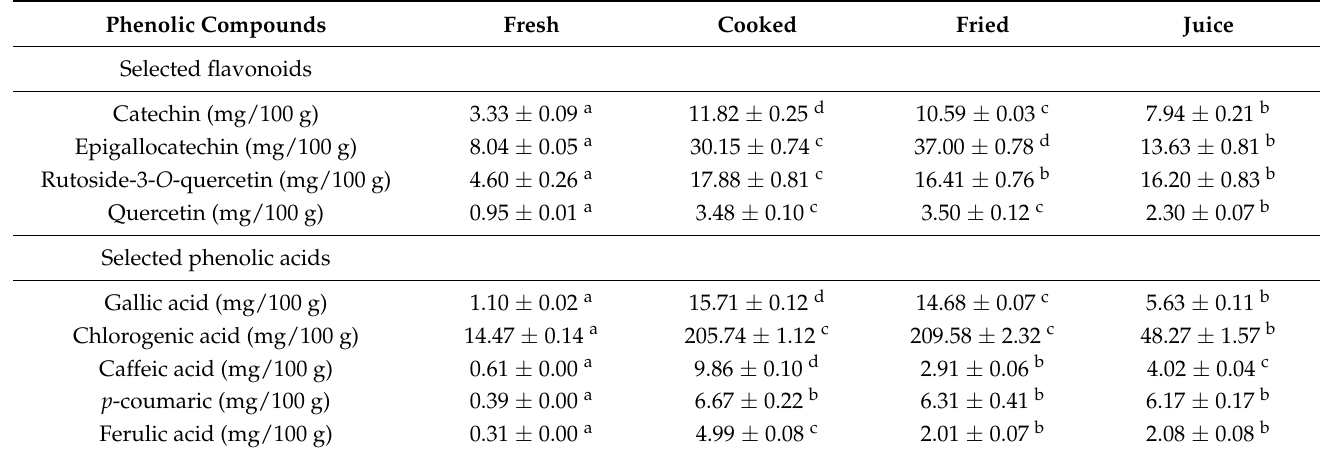
Table 4. Selected phenolic compounds in fresh quince fruit and its